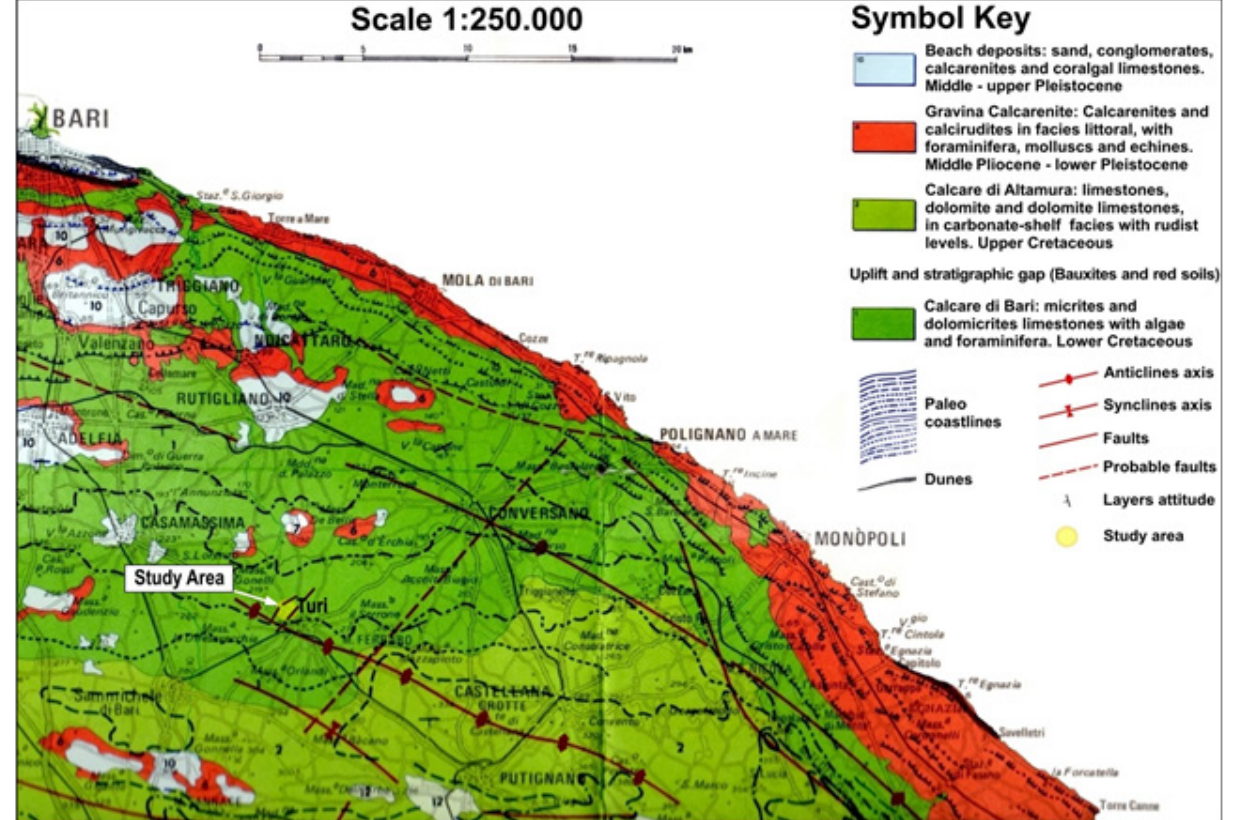
Figure 2: Geological map of the territory in which the study area is located (from [16]